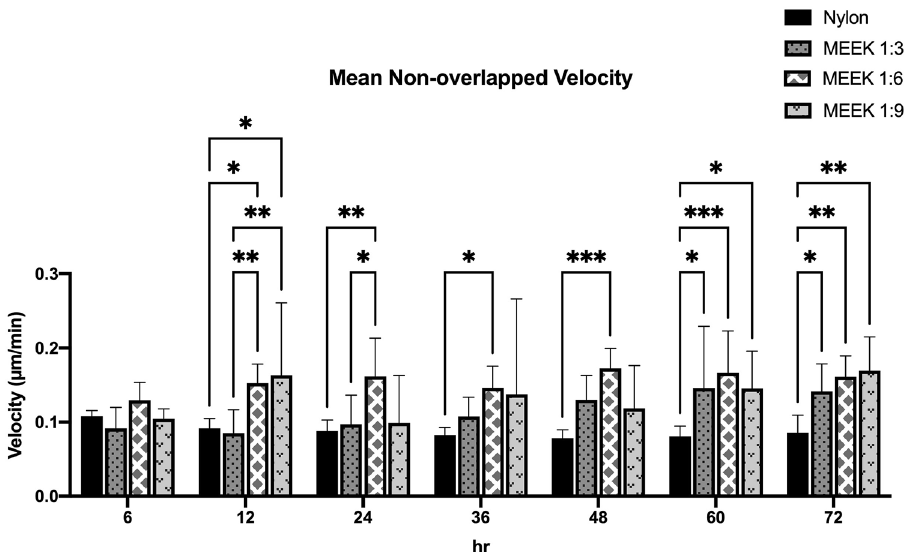
Figure 6. Mean nonoverlapping velocity of fibroblast cells on nylon dressing and MEEK gauzes. The migration velocities of fibroblasts on nylon dressing and MEEK gauzes at 1:3, 1:6 and 1:9 expansion ratios were determined at 6, 12, 24, 36, 48, 60 and 72 h. The results are shown as the mean ± SD (n = 5). Statistically significant differences were determined using two-way ANOVA with Tukey’s multiple comparisons test, in which *p < 0.05; **p < 0.01, and ***p <